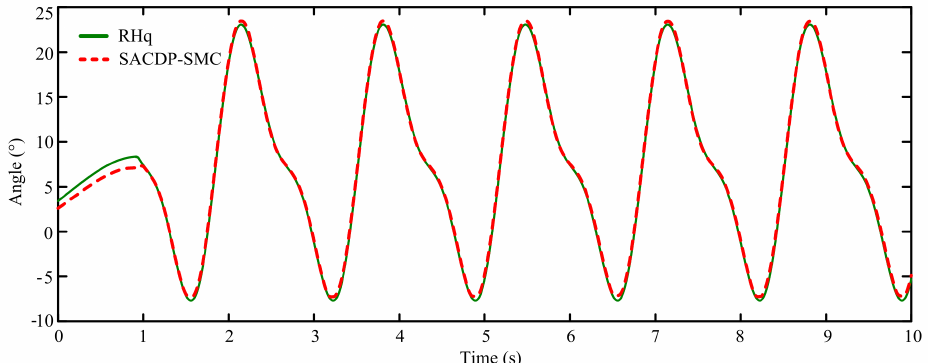
Figure 9. Motion states of the tester in complete gait cycle.